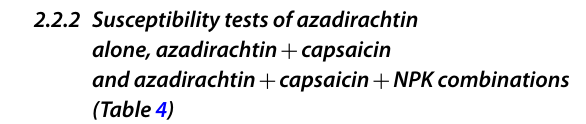
Table 2 Activity of NPK azadirachtin combination (observed + and expected mortalities) against susceptible strain IRD Aedes albopictus